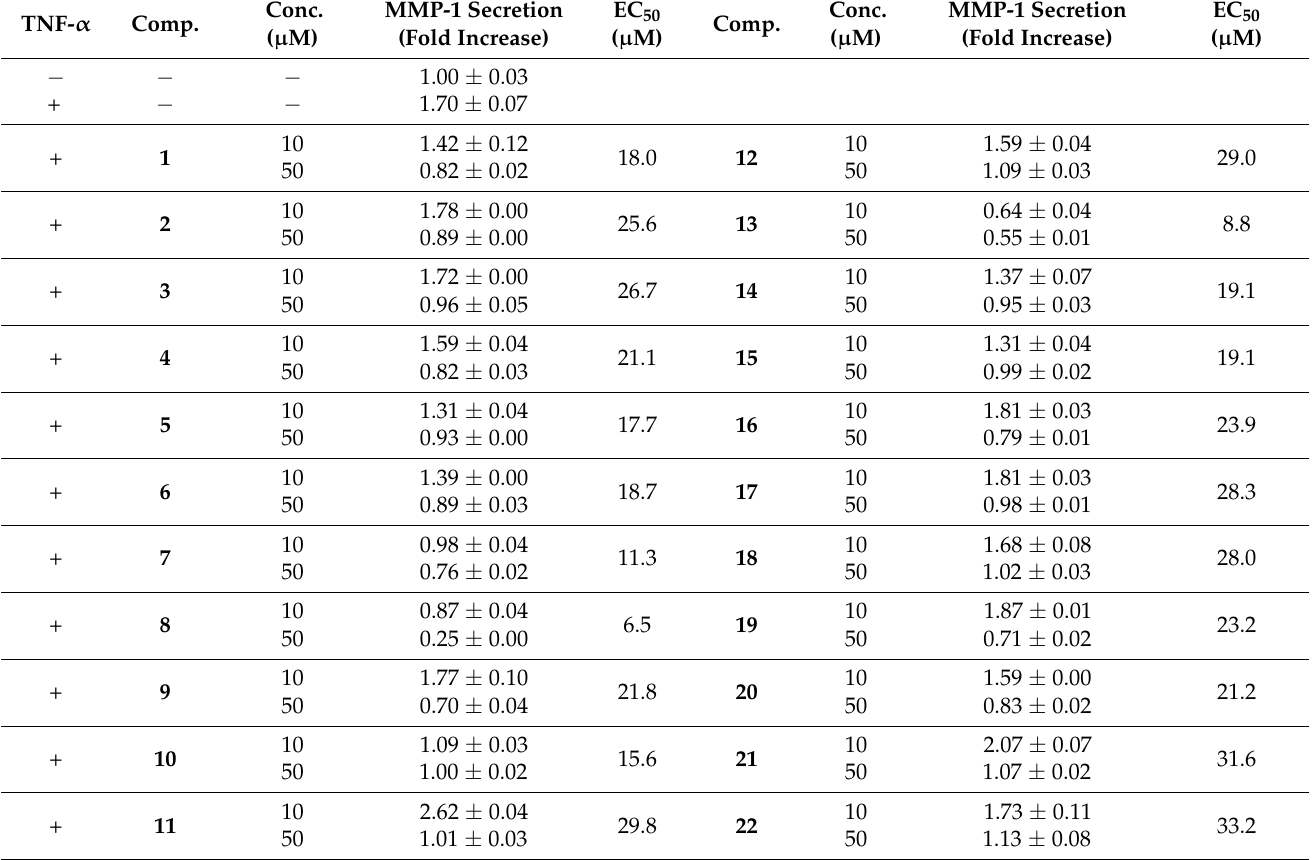
EC 50 : the concentration of compound that produces 50% inhibitory